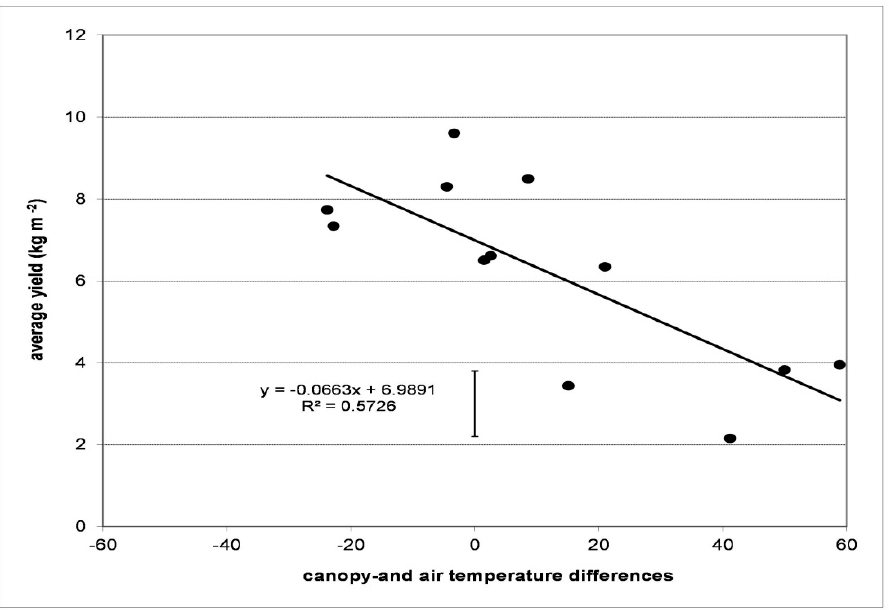
Figure 4. Correlation between canopy and air temperature di ff erences and yield Source: [ 31 ].